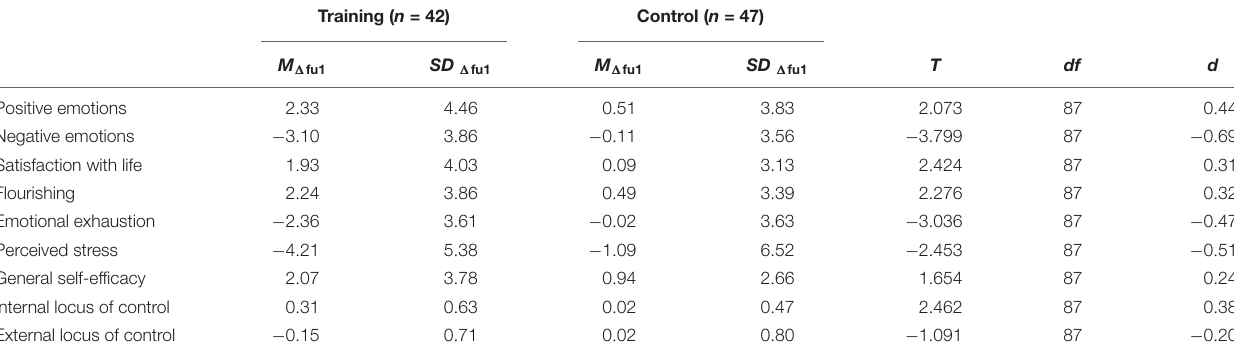
TABLE 6 | Between-group differences of within-group differences between t3 and t1 (pre – follow-up1).